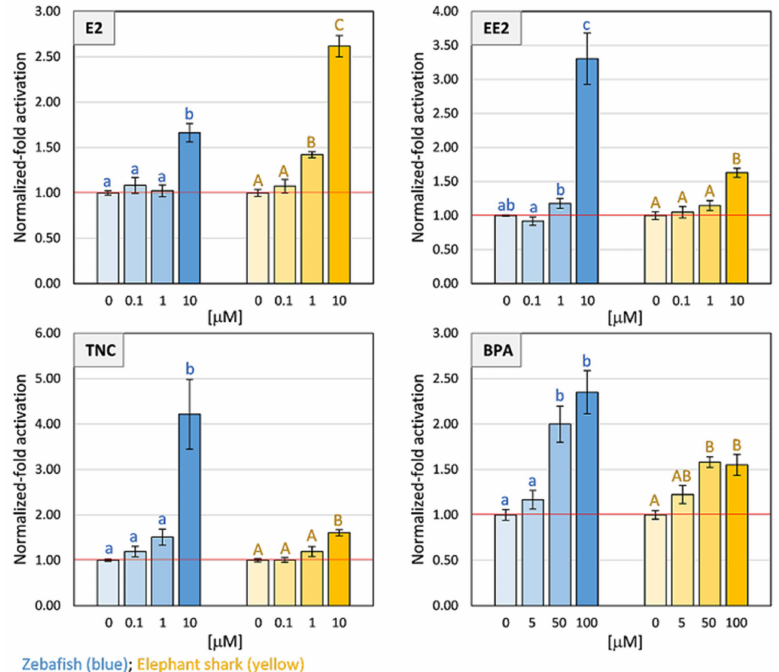
Figure 4. Transactivation activity of luciferase reporter gene performed in COS-1 cells mediated by the PXR ligand binding domain (LBD) pBIND constructs in the presence of 17 β -estradiol (E2), 17 α -ethinylestradiol (EE2), trans-nonachlor (TNC), and bisphenol A (BPA). Data represent means ± standard error of the mean (SEM) from three separate experiments ( n = 3). The results were normalized to the control condition (DMSO without ligand). The red horizontal line represents the level of the control condition (no fold activation). Significant di ff erences between the tested concentrations and the solvent control were inferred using one-way ANOVA. The lowercase letters (zebrafish) and the uppercase letters (elephant shark) were used to mark significant di ff erences ( p <